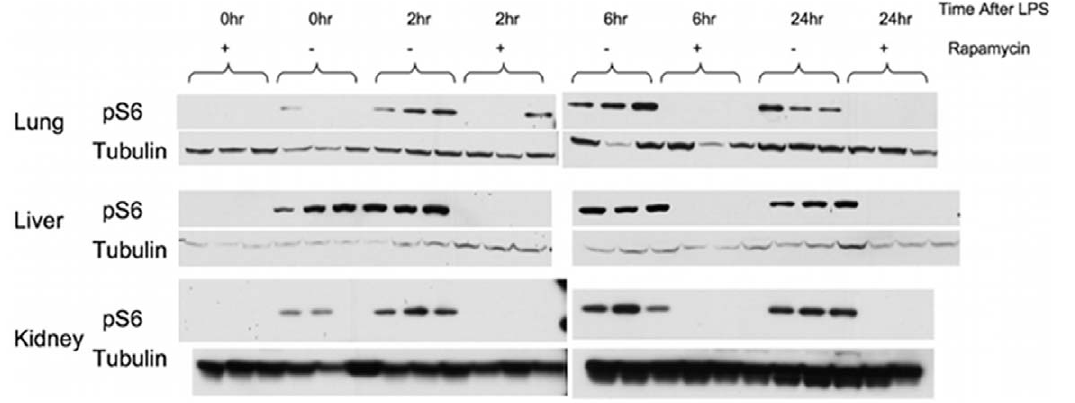
Figure 2. Rapamycin treatment effectively suppressed mTORC1-S6K signaling. Following LPS challenge in vivo, mice were treated with vehicle or 6 mg/kg rapamycin 30 min prior to 25 mg/kg LPS challenge. Organs were harvested from mice at 2, 6, 24 hr post challenge. Immunoblots of organs extracted from 3 mice from each treatment group probed for pS6 (S240/244), a downstream target of mTORC1-S6K are shown here. Unchallenged mice with or without rapamycin served as controls (time 0 hr). Rapamycin treatment successfully suppressed mTORC1-S6K up- regulation in endotoxemic mice as reflected by the near-absent pS6 signals.